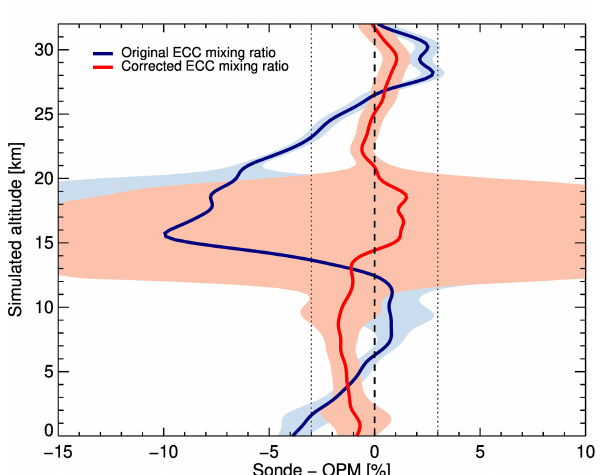
Figure 7. Ozone profile measured at Costa Rica. The original pro- file is shown in blue, the reprocessed profile in red. The right-hand profile shows the difference of the reprocessed profile minus the original profile.